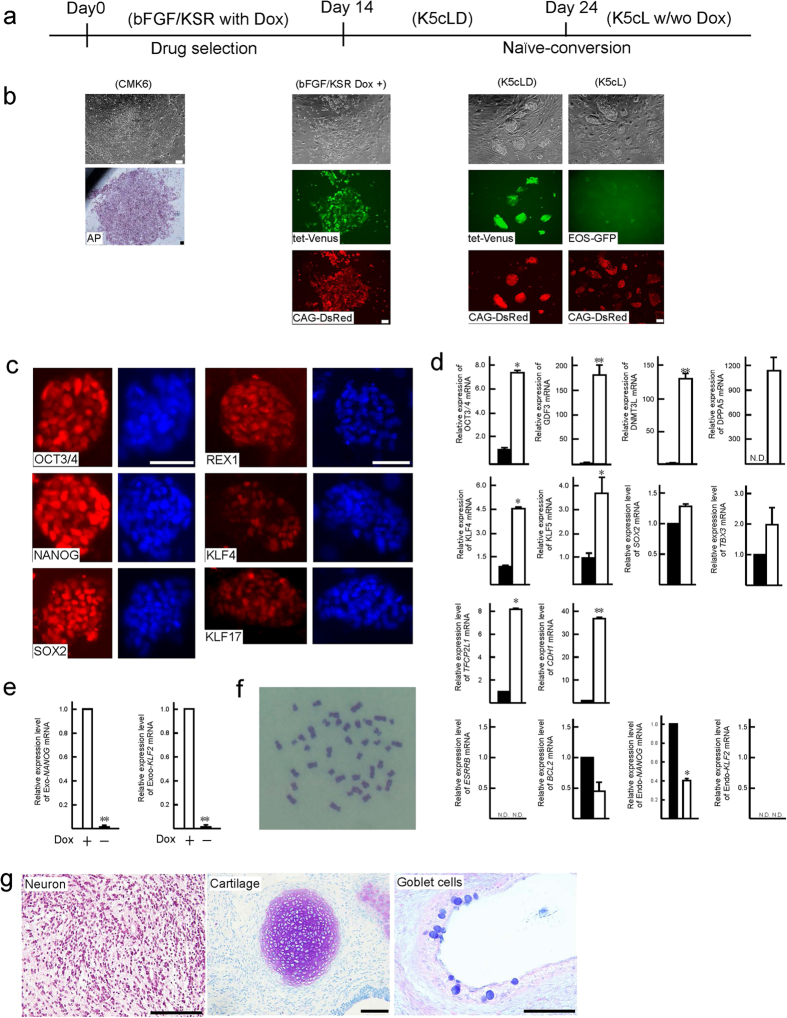
Naïve-like conversion of cynomolgus monkey (Cm) ESCs.(a,b) Schematic representation of time schedule (a) and representative images (b) of the naïve-like conversion of a Cm ESC line, CMK6, observed at different stages during naïve-like conversion. AP, alkaline phosphatase activity. Scale bar = 100 μm. (c) Immunocytochemical analysis of the CMK6 cell line that had been converted into a naïve-like state, using antibodies (OCT3/4, NANOG, SOX2, REX1, KLF4, and KLF17) directed against markers of naïve pluripotency-related proteins. Scale bar = 50 μm. (d) RT–qPCR for naïve pluripotency-related transcripts before (closed bars: primed) and after (open bars: naïve-like) naïve-like conversion. Error bars indicate the standard deviation (S.D.) *P < 0.05; **P < 0.01. (e) RT–qPCR confirmation of the expression and silencing of Exo-hNANOG and Exo-hKLF2 in the presence (+) or in the absence (−) of Dox. (f) Normal number (2n = 42) of metaphase chromosomes confirmed in naïve-like converted CMK6 cells at passage 12. (g) Teratoma formation by naïve-like converted CMK6. Various tissues of the three germ layer origins are identified: neurons stained with haematoxylin and eosin (ectoderm), hyaline cartilage stained with Toluidine blue (mesoderm), and goblet cells stained with Alcian blue (endoderm). Scale bar = 100 μm.